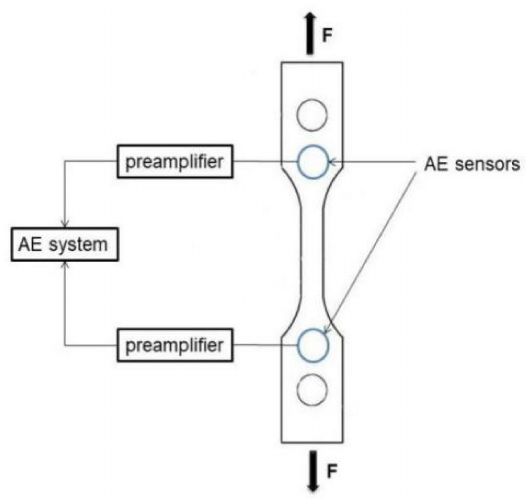
Figure 4. Schematic diagram of signal